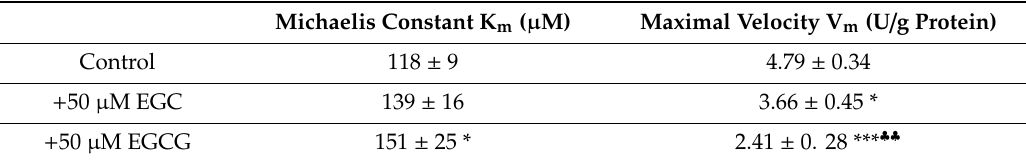
Figure 3. Lineweaver–Burk plot of erythrocyte membrane acetylcholinesterase activity in the absence and in the presence of 50 μM ( – )-epigallocatechin (EGC) and 50 μM ( – )-epigallocatechin gallate (EGCG). Table 4. Effect of EGCG on the kinetic parameters of erythrocyte membrane acetylcholinesterase. Mean values ± SD, n ≥ 3.